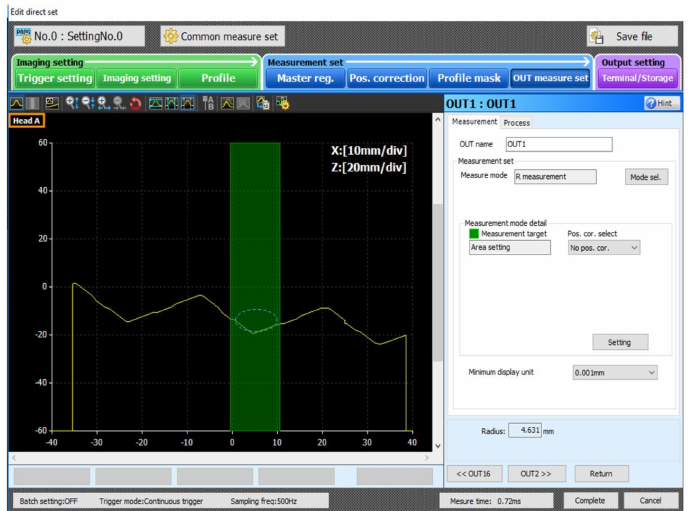
Figure 15. Definition of the measurement area rectangle and the determination of the fillet radius value in the Keyence